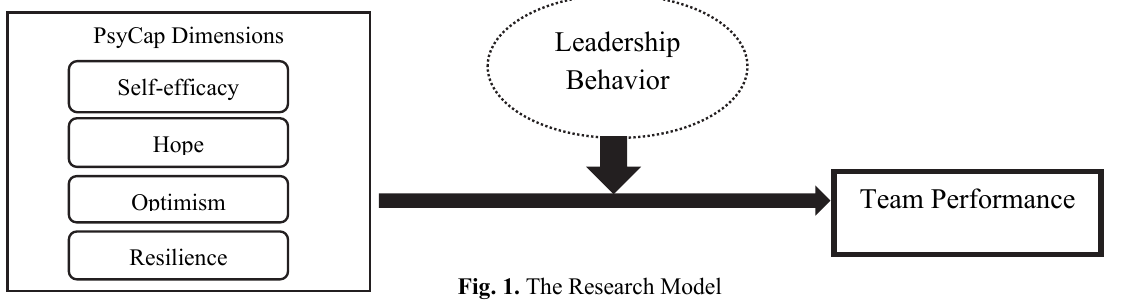
Fig. 1. The Research Model